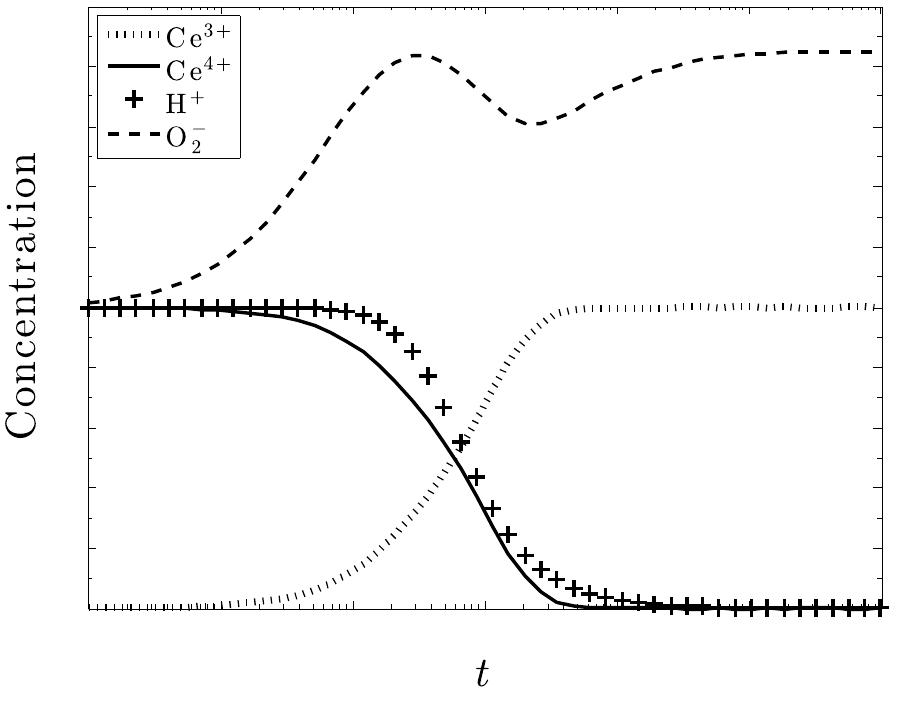
Figure 10. In this case, the amount of hydroxide is triple the amount of the other species. With all the rate constants set equal to each other, the amount of superoxide increases from its initial amount.